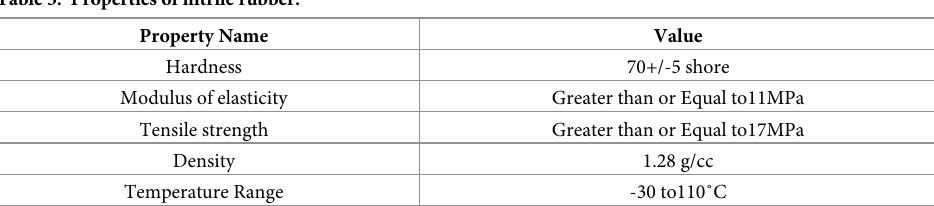
Table 3. Properties of nitrile rubber.